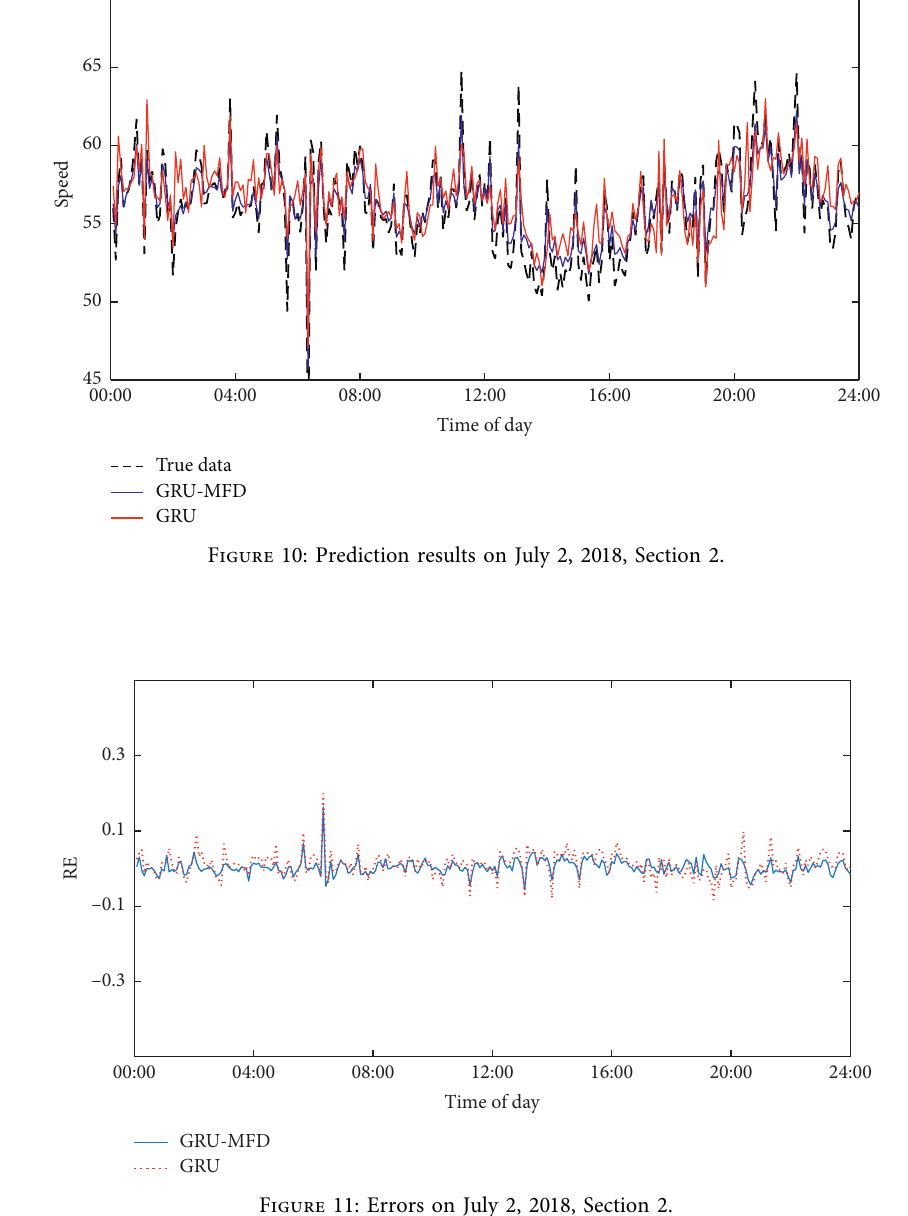
acceptable prediction results. The results of error evalua- tion indicators MAPE and RMSE are shown in Table 6.